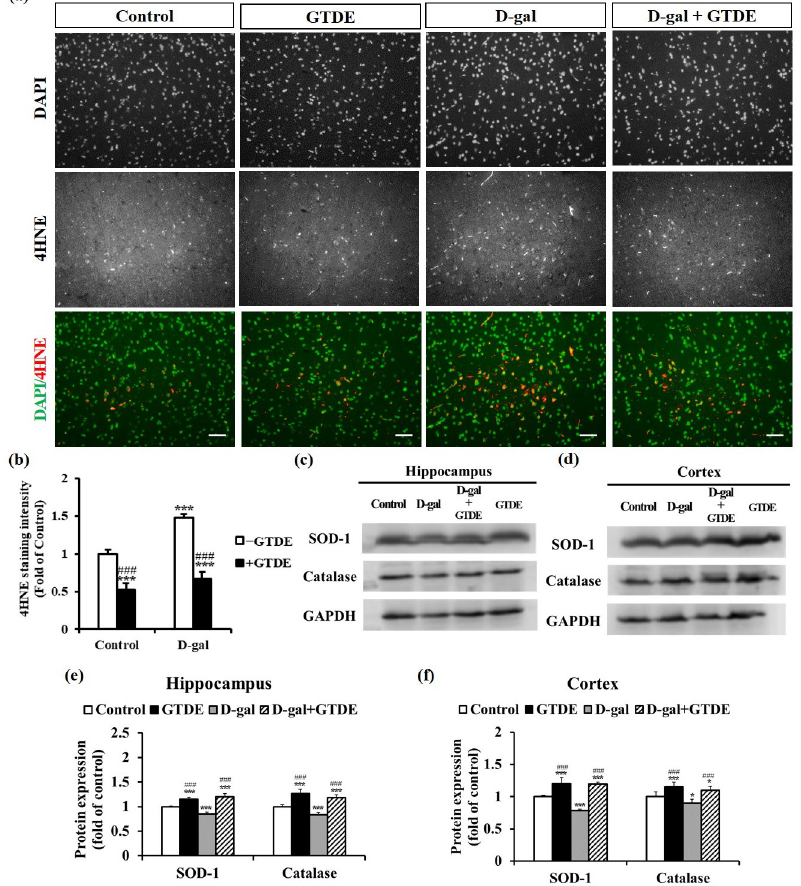
rats (scale bar = 50 μ m). n (images) value = 21 (control); 20 (GTDE); 23 (D-gal); 21 (D-gal+aging). (b) Quantitative results of 4-HNE staining intensity. (c) to (f) Western blots of the proteins obtained from the homogenization of the hippocampal and cerebral cortical tissues of the rats. The changes in SOD-1 and catalase expressions were compared with the use of GAPDH as the loading control. n = 9. (c) and (d) Representative western blots for the hippocampus and cerebral cortex, respectively. (e) and (f) Corresponding quantified results. Intergroup differences were compared using one-way ANOVA followed by the Tukey’s multiple comparisons test. Statistically significant differences based on comparisons with the control group are denoted by � P < 0.05, �� P < 0.01, ��� P < 0.001; statistically significant differences based on comparisons with the D-gal group are denoted by # P < 0.05, ## P < 0.01, ### P <